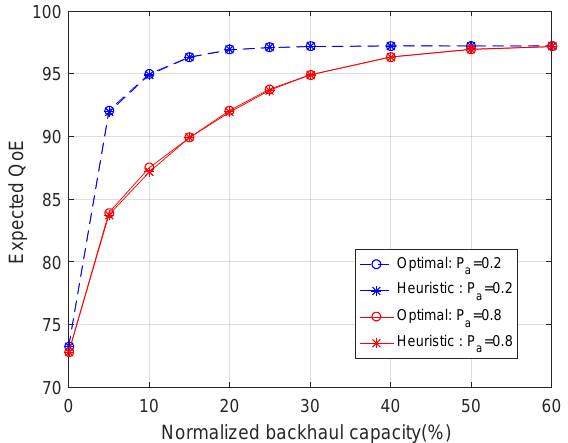
Figure 9. The expected QoE as a function of the normalized backhaul capacity in the single time slot optimization problem ( S = 200